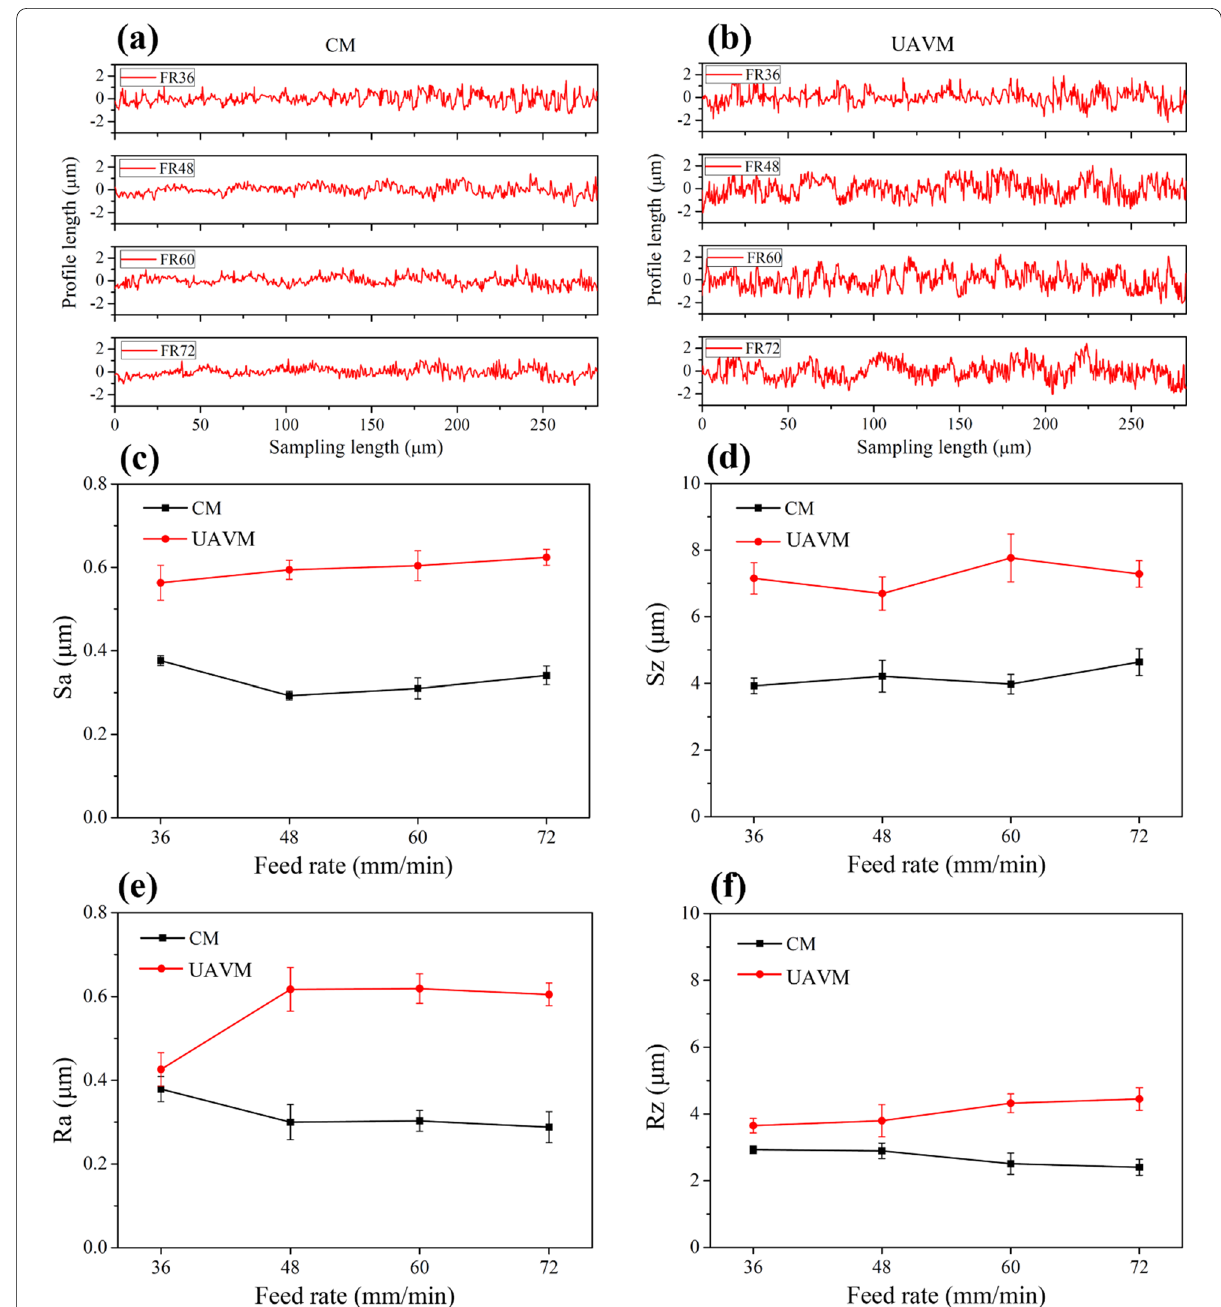
Figure 7 Surface profiles and surface roughness: a and b are the line-scanning profiles of surfaces machined under different conditions after CM and UAVM, respectively, c and d are the corresponding area roughness (Sa and Sz), e and f are the corresponding profile roughness (Ra and Rz)(FR means feed